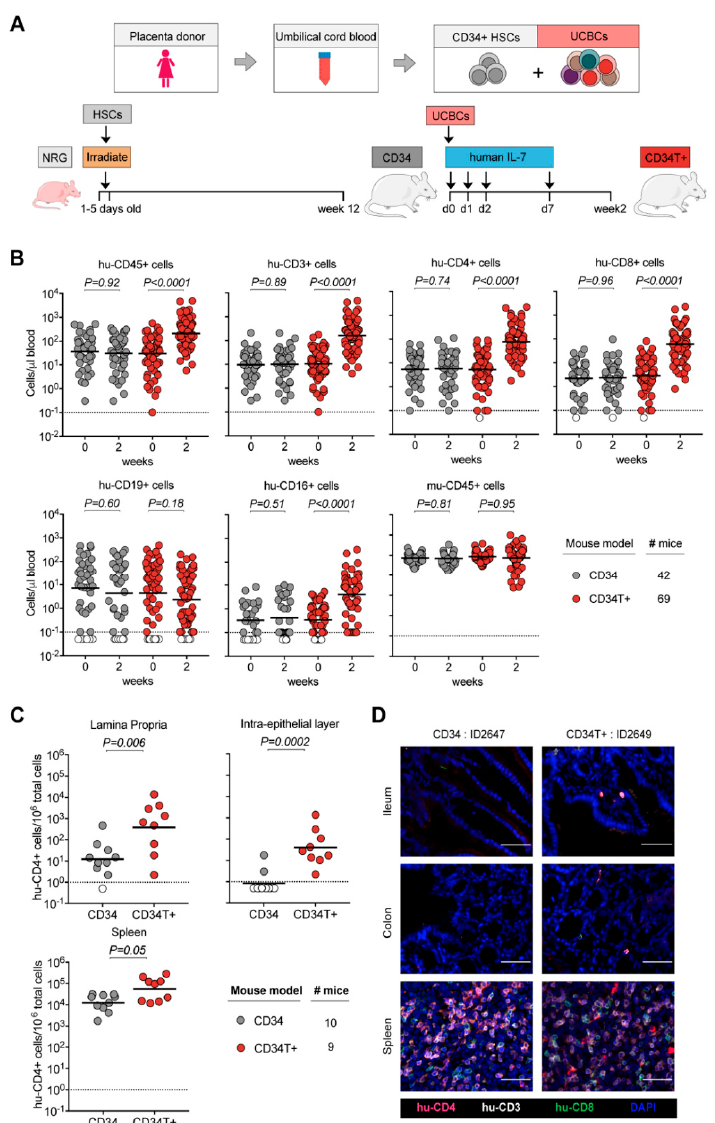
Figure 1. Generation of CD34T+ mice with enhanced reconstitution levels of human cells. ( A ) Human umbilical cord blood from each donor was processed and stored as CD34+ HSCs and UCBCs. 1–5 days old NRG mice were subjected to sub-lethal irradiation and intra-hepatic injection of CD34+ HSCs. At 12 weeks of age, mice that had positively engrafted human leukocytes were termed CD34 mice. To obtain CD34T+ mice, CD34 mice were injected with donor-matched UCBCs and human-IL-7 at the indicated time-points. Two weeks post UCBC injection, the resulting mice were termed CD34T+. ( B ) FACS analysis of leukocyte populations in the blood of CD34T+ mice before UCBC injection (week 0) and 2 weeks after UCBC injection (week 2) along with untreated CD34 mice analyzed in parallel. Points shown in white were below limit of detection of assay. Statistical analysis done using Wilcoxon matched-pairs signed rank test ( C ) FACS analysis of CD34 and CD34T+ mice for the presence of human CD4+ T cells in the gut LP, IEL and the spleen at week 2. Points shown in white were below limit of detection of assay. Statistical analysis was done using Mann-Whitney U test. ( D ) IF analysis of human T cells in the ileum, colon and spleen of CD34 and CD34T+ mice at week 2. Human CD3+ (white), CD4+ (red), CD8+ (green) cells were labeled for detection along with DAPI for visualizing the nucleus. Scale bar is 50 μ m. Three mice per group were analyzed with at least three different slices from different areas of each mouse tissue being analyzed. Representative images were selected for display.